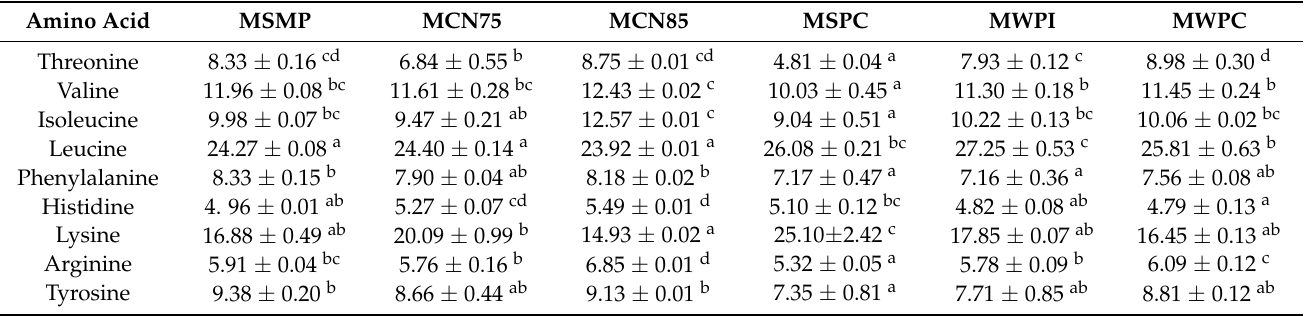
Table 1. Amino acid profile of non-fermented milks enriched with protein preparations, g/100 g of amino